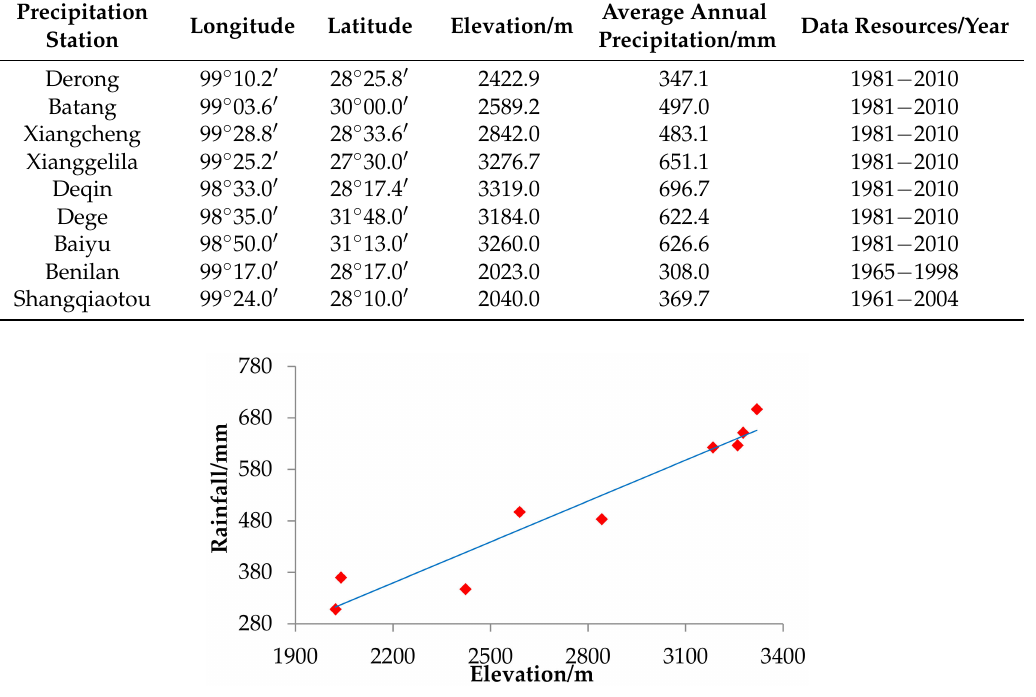
Figure 3. The relationship between elevation and average annual precipitation based on the nine precipitation